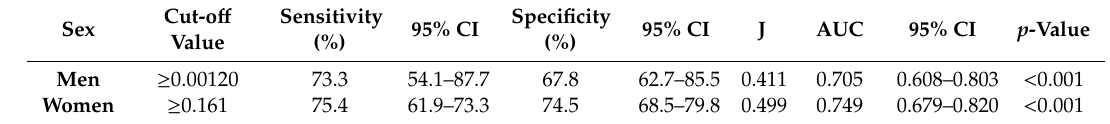
Table 4. The performance of the new osteoporosis screening